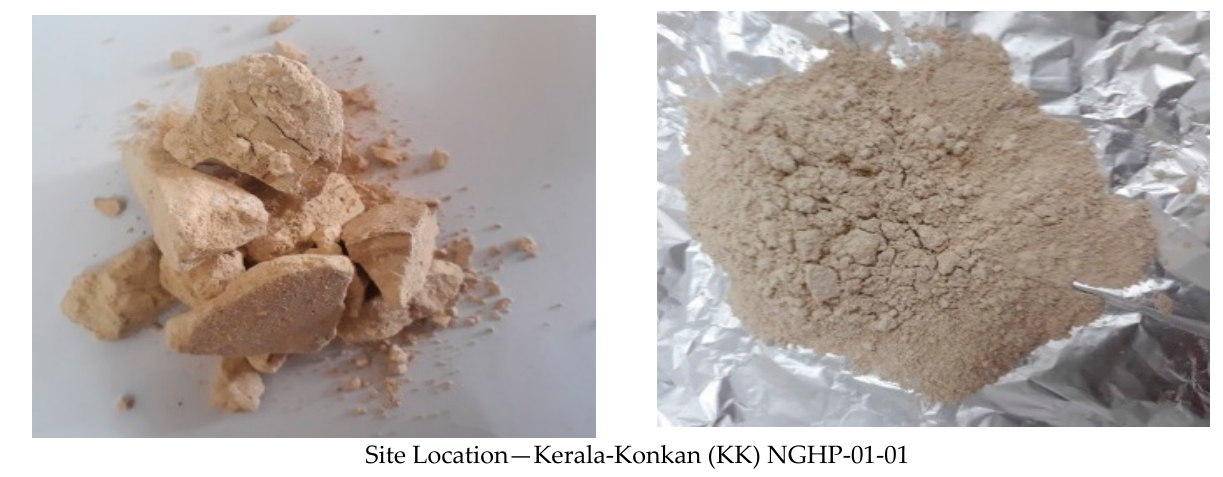
Figure 2. Hydrate-bearing sediment samples. Table 1. Testing equipment used for different characteristics of hydrate-bearing sediments.